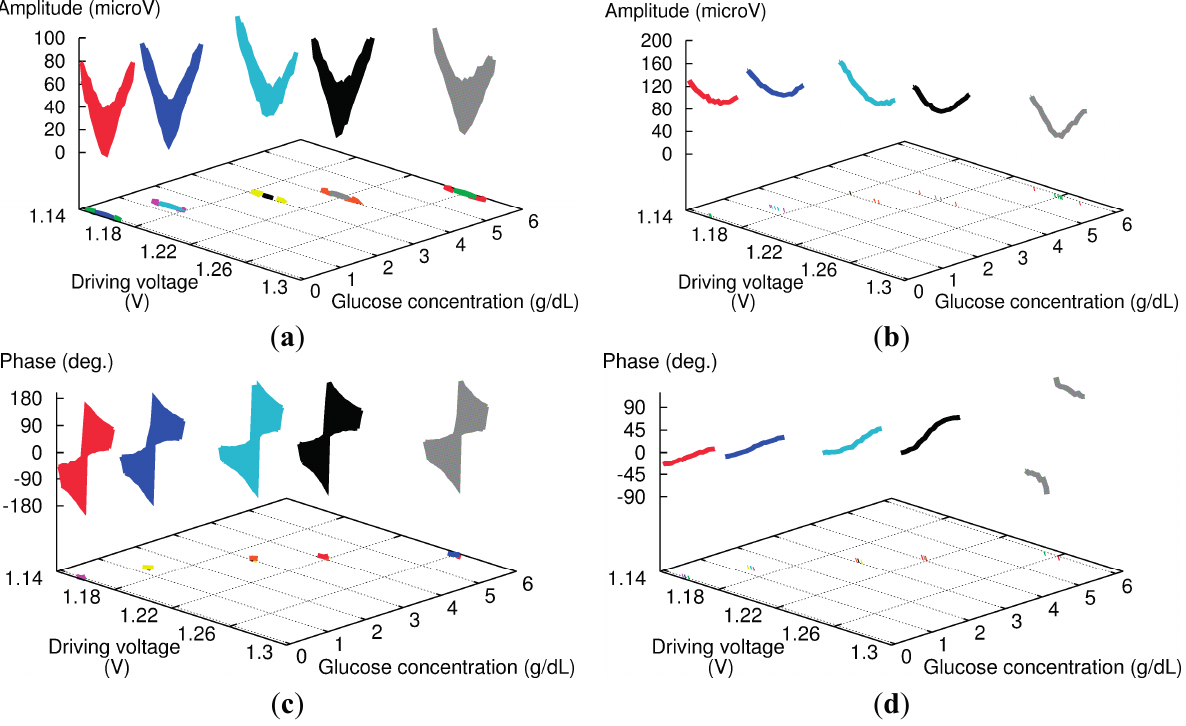
Figure 7. Experimental amplitude ( a , b ) and phase ( c , d ) results for 180-phase difference set at the fiber coupler ( a , c ) and FG ( b , d ) for aqueous glucose solutions with high concentration